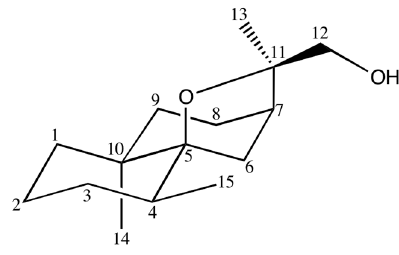
Figure 5. Structure of 12-hydroxyisodihydroagarofuran ( 39 ). Table 3. NMR data of 12-hydroxyisodihydroagarofurane ( 39 ).